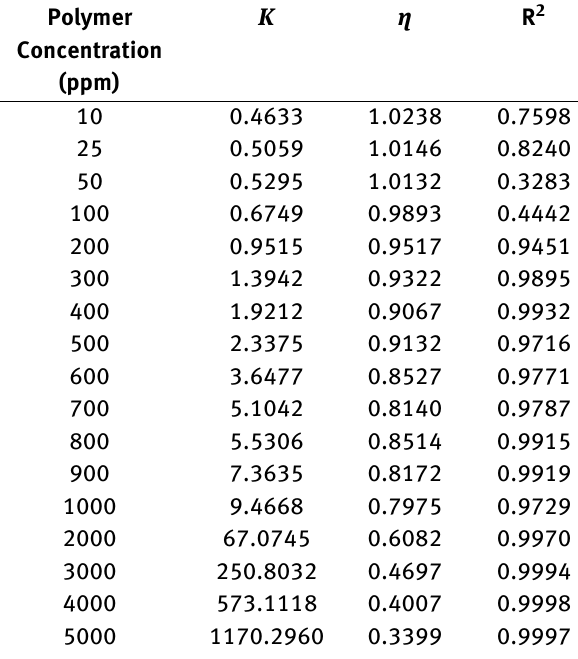
Table 10: Fit parameters to the Power Law Model for 77 ∘ C/110,000 ppm NaCl Polymer